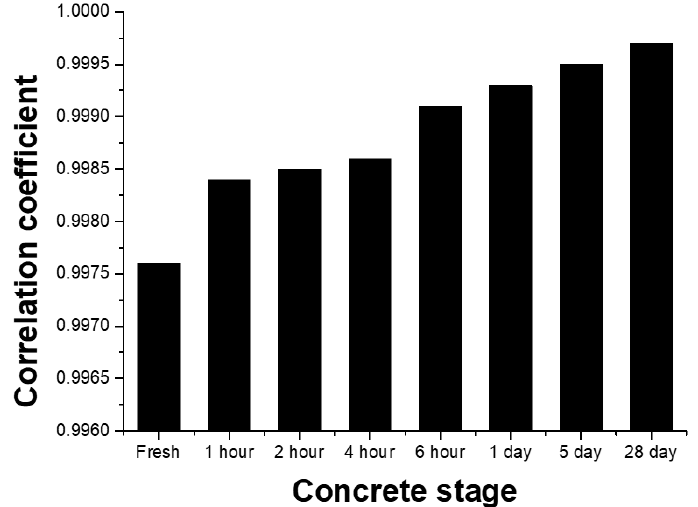
Figure 9. Correlation coefficient value between the actual and predicted gap in the steel-concrete composite specimen at different stages of concrete curing.